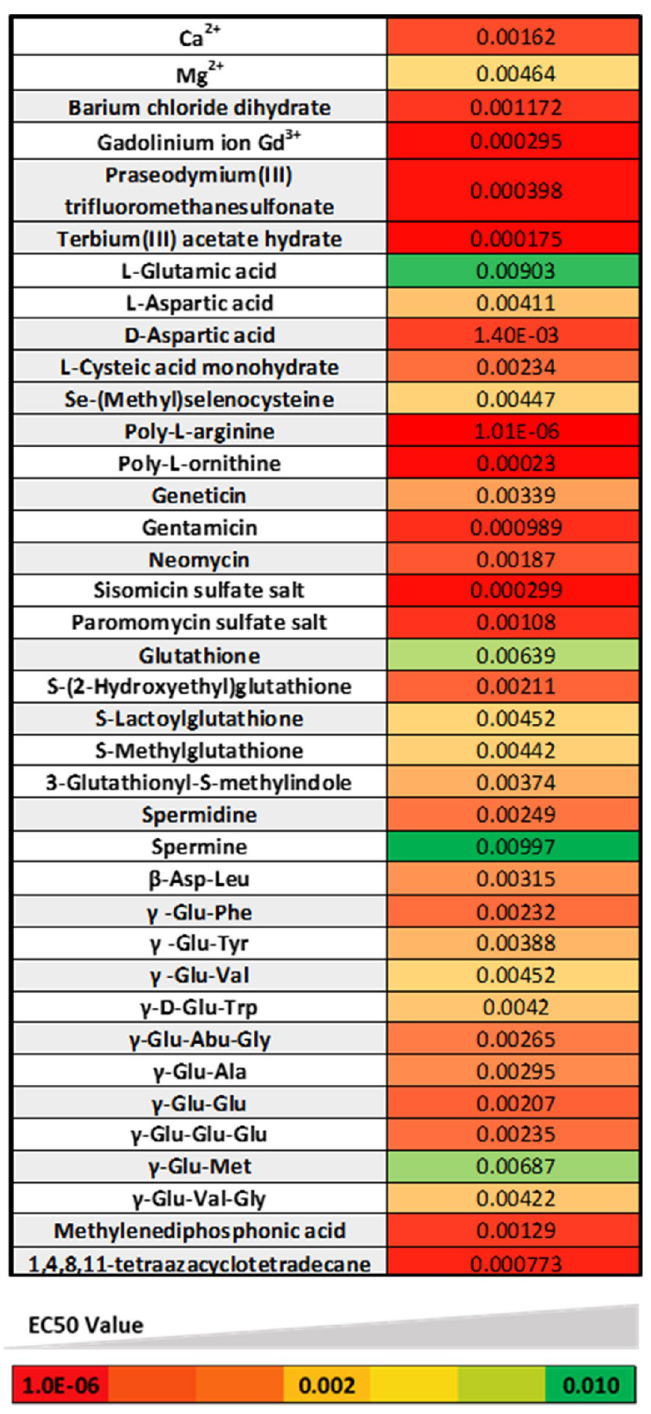
Figure 5. Heat map generated with CaSR agonists, classed according to their affinity for cCaSR. The Compounds with higher affinities (low µM range) appear in bright red, compounds with medium affinity in different hues of orange (mid to high µM range), and finally the compounds with lower affinities with the receptor are colored in green (mM